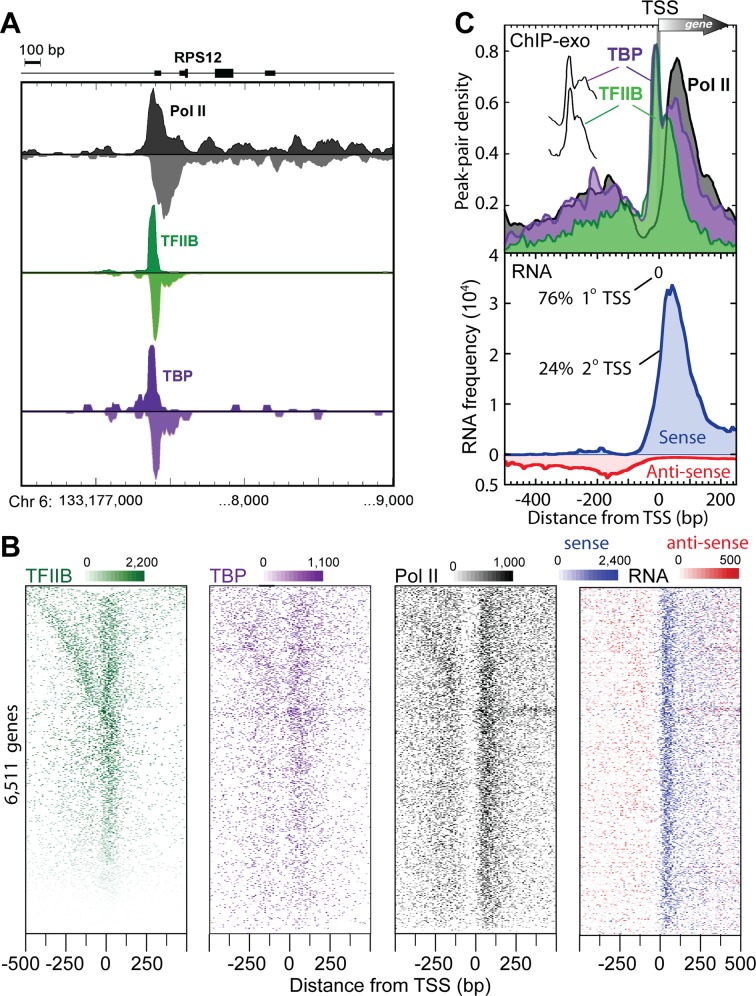
Transcription machinery organization at human mRNA promoters.(A) Smoothed distribution of strand-separated ChIP-exo tag 5′ ends at the RPS12 gene. (B) ChIP-exo peak-pair or RNA distribution at RefSeq genes (rows). Rows are linked, and sorted by distance between adjacent TFIIB peak-pairs. (C) Upper panel: Averaged ChIP-exo patterns around the closest (1°) RefSeq TSS. Peak-pair tags were aligned to the TSS gene-by-gene, binned in non-overlapping 10 bp intervals relative to the TSS, and then the average peak-pair density value across all TFIIB-occupied (n = 6,511) genes was plotted as a percent of the total. The “spikes” of TBP and TFIIB are indiscernible (vertically offset in inset). Lower panel: Distribution of 2° polyadenylated RNA [39], with traces separated by sense (blue) and antisense (red, inverted trace) orientations relative to the corresponding mRNA TSS.